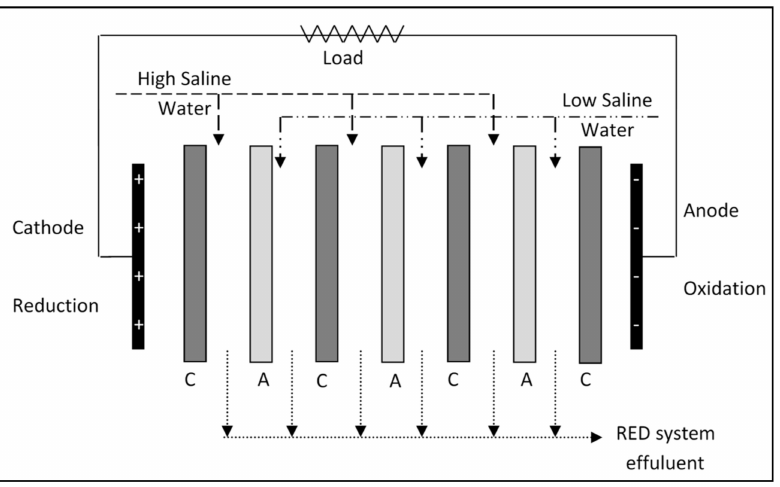
Figure 1. Schematic of the reverse electrodialysis (RED) system (C: cation exchange membrane; A: anion exchange